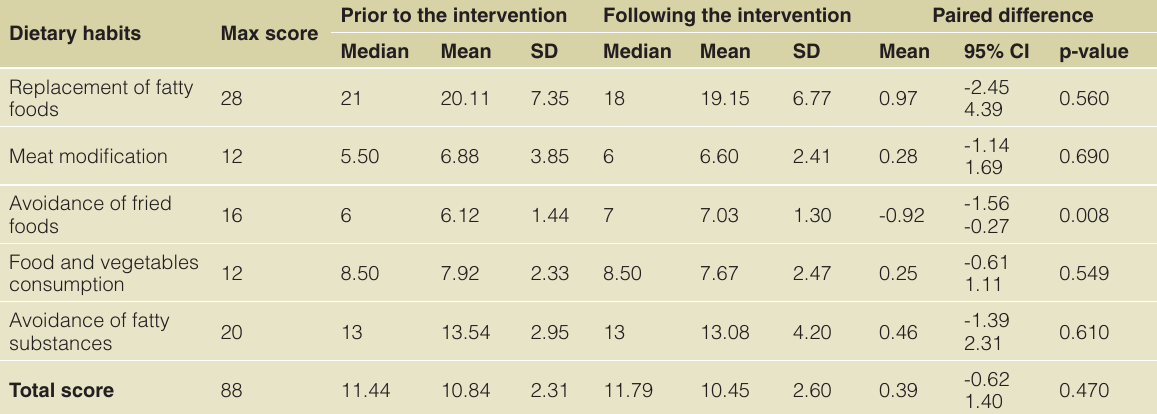
Table 4. Comparison of dietary habits score per dietary habit category prior to and following the intervention (n=20). Prior to the intervention Dietary habits Max score Replacement of fatty